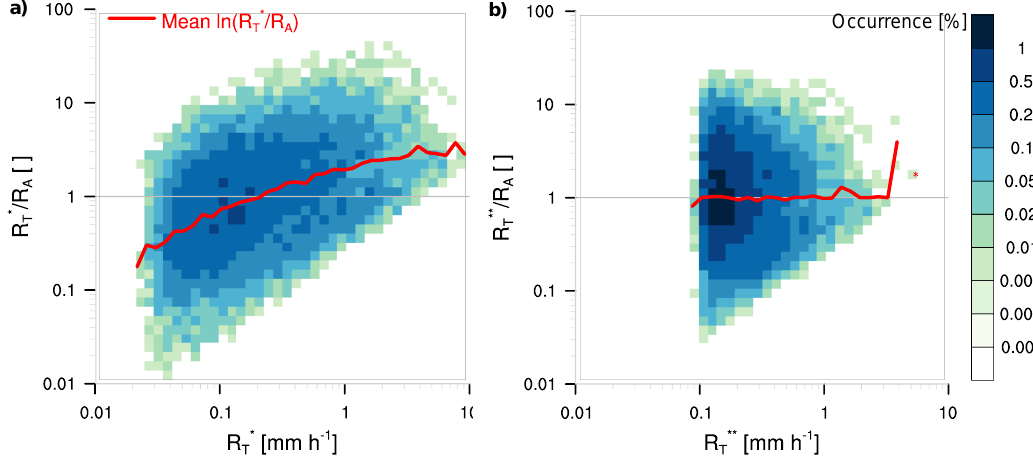
∗ T ; R A and R ∗∗ , T T